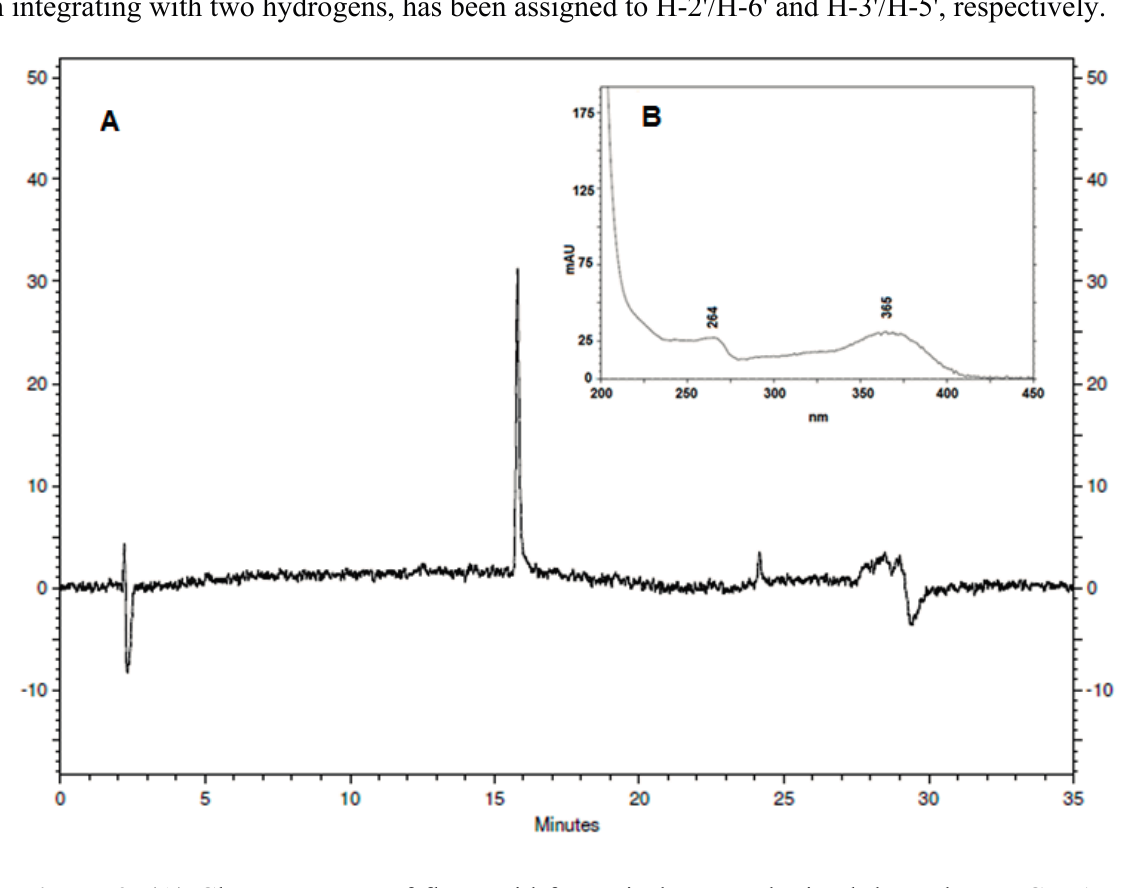
Figure 3. ( A ) Chromatogram of flavonoid from sisal waste obtained through HPLC-DAD (365 nm); ( B ) UV spectra of peak at 15.7